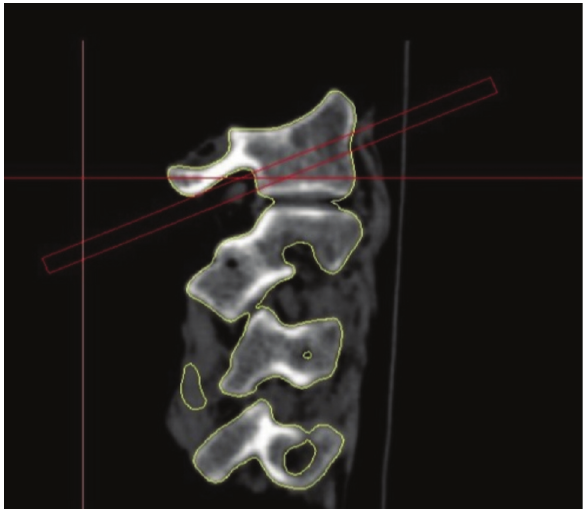
Sagittal CT from first vertebrae used for surgical Fig. 2: planning.